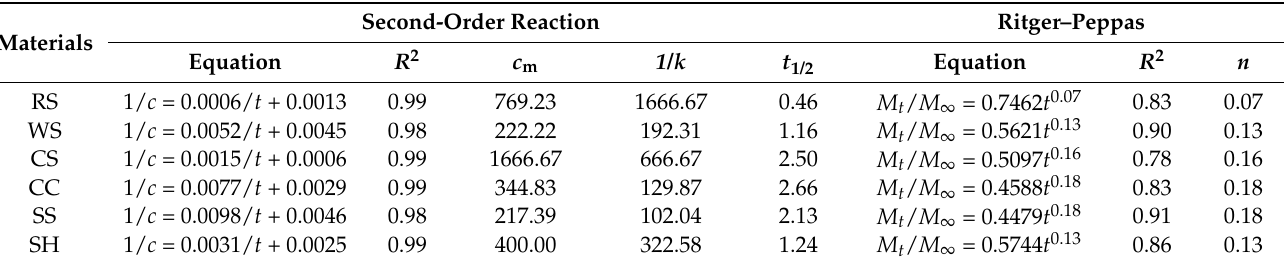
Table 2. Kinetic fitting results of the carbon release